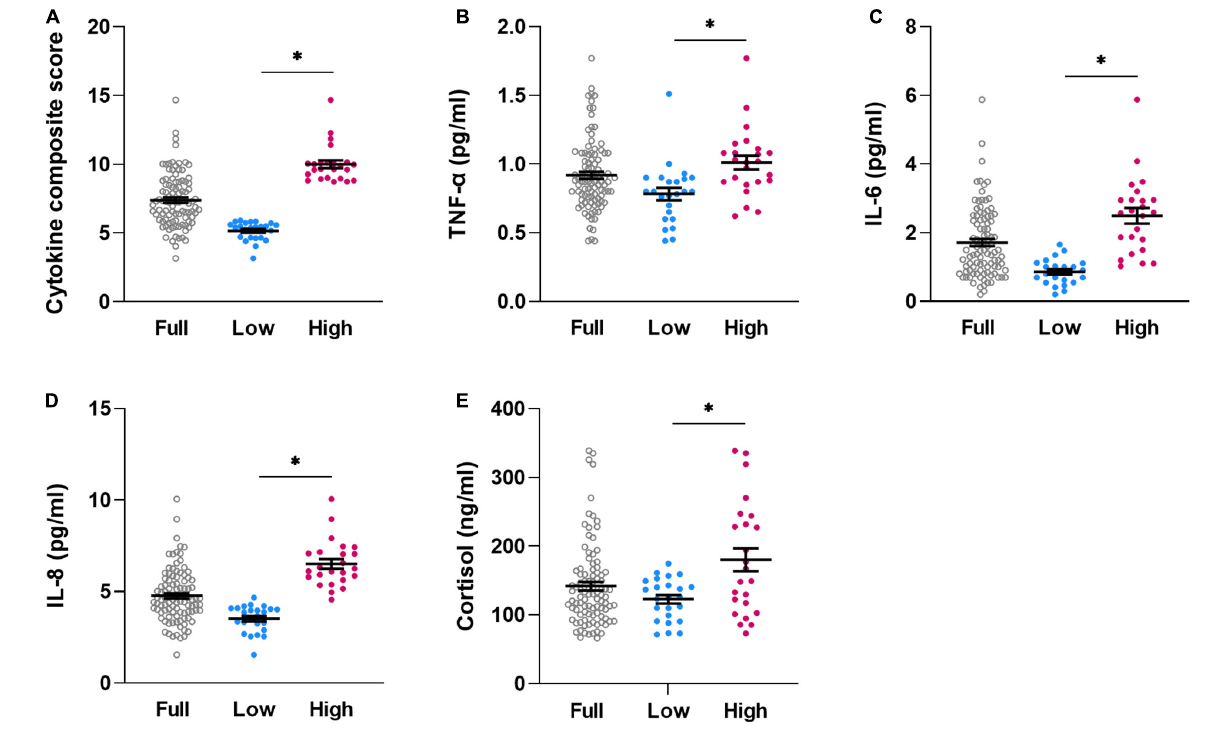
FIGURE 1 | Individual dataplots for cytokine composite score (A) , plasma concentration of TNF- α (B) , IL-6 (C) , IL-8 (D) , and cortisol (E) for the full sample (full, N = 98), lowest quartile (low, N = 24)) and highest quartile (high, N = 24) subgroups based on cytokine composite score. *significant differences between subgroups, for details, see Table 1 . Lines within plots indicate mean and